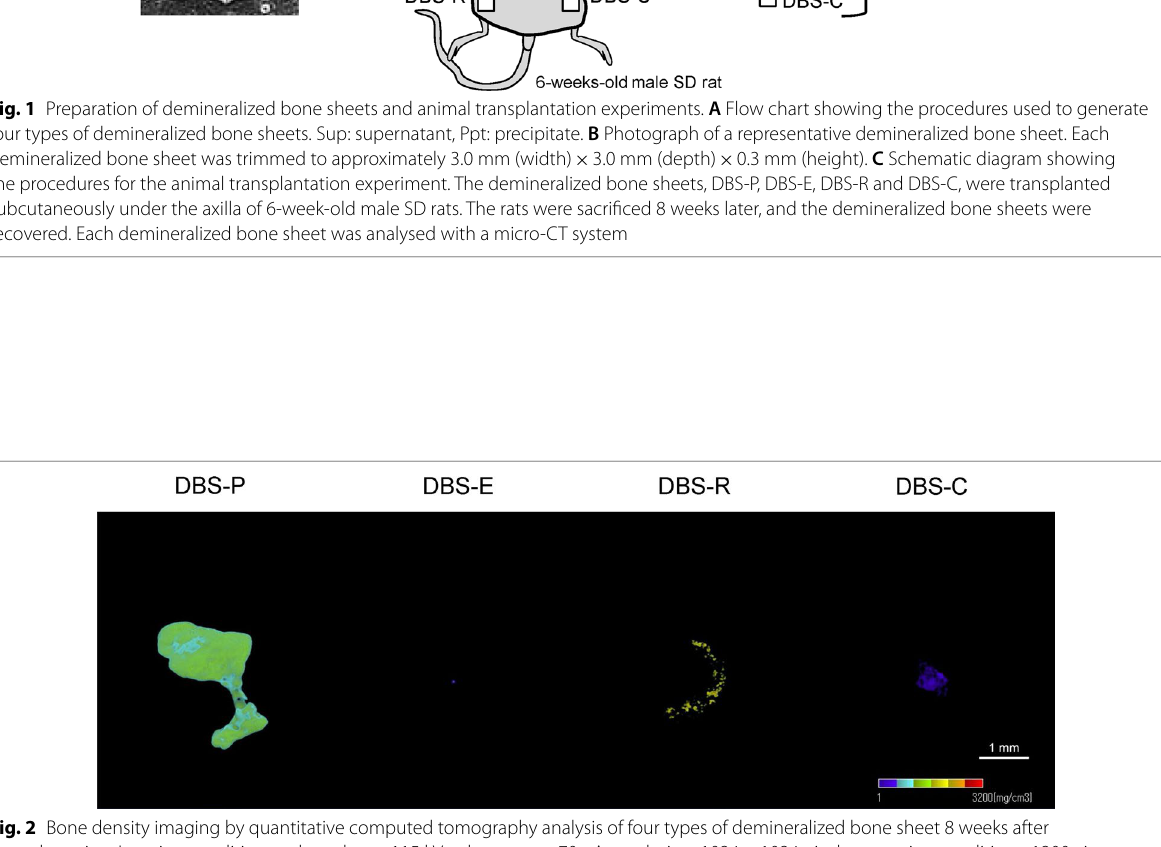
1024 pixels; operating conditions, 1200 views; ×